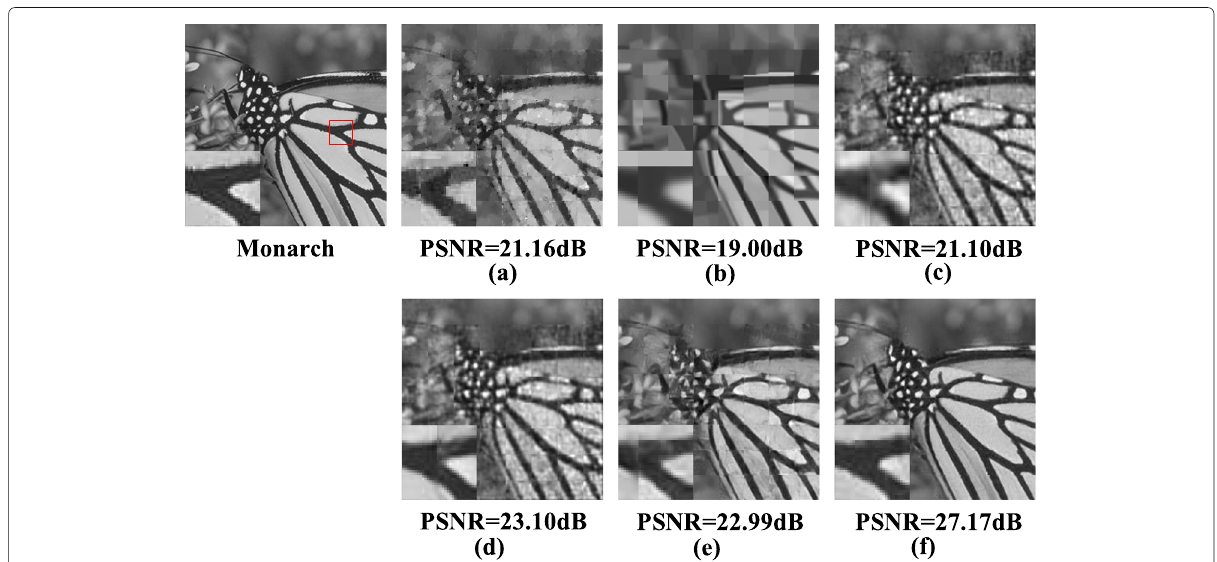
Fig. 7 The reconstruction results of Monarch at the measurement rate of 0.1 without BM3D. a TVAL3. b DAMP. c ReconNet. d DR 2 -Net. e CSRNet.